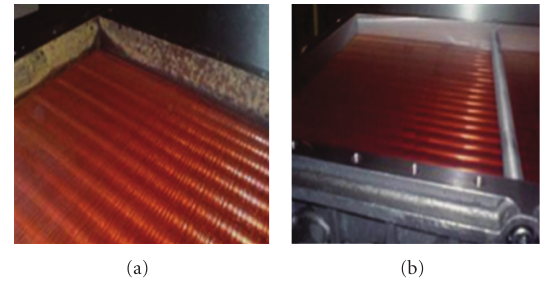
Figure 7: Heat exchangers manufacturing process. (a) without corrosion inhibitor in cleaning process. (b) Molybdate and nitrite were applied 180 :120 ppm to inhibit galvanic